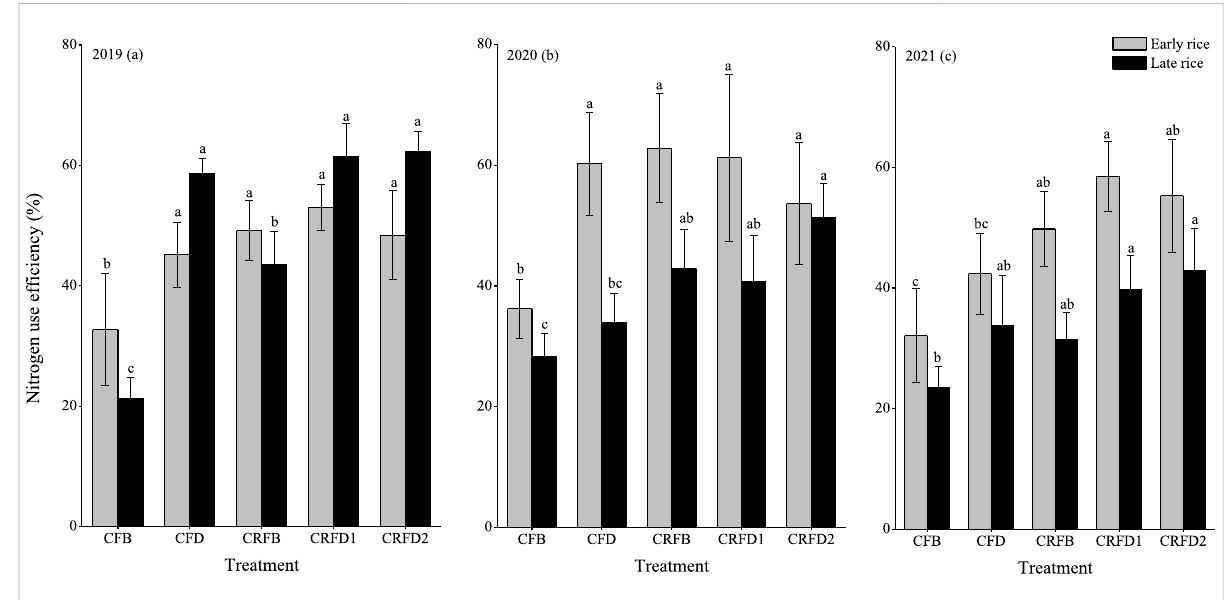
FIGURE 6 The N use ef fi ciency for early and late rice under different treatments in 2019 (A) , 2020 (B) and 2021 (C) . Values are presented as the mean ± standard deviation ( n = 3). Different lowercase letters above the column indicate signi fi cant difference at p < 0.05. N0: no N fertilizer; CFB: compound fertilizer broadcasting; CFD: compound fertilizer side-deep placement; CRFB: controlled-release N fertilizer broadcasting; CRFD1: controlled-release N fertilizer side-deep placement; CRFD2: controlled-release N fertilizer side-deep placement, one-time